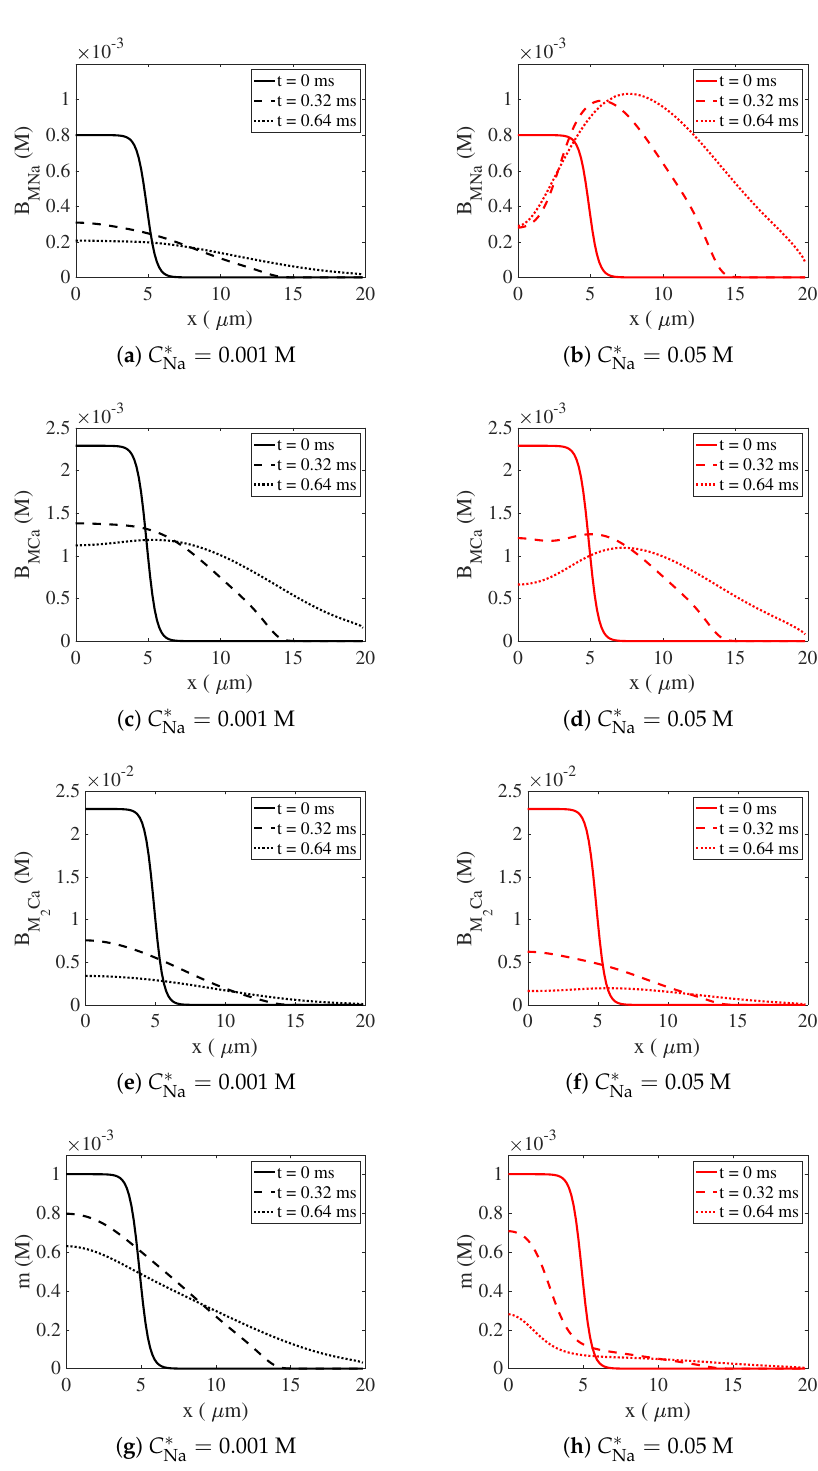
= 0.001 M and ( b , d , f ) Na